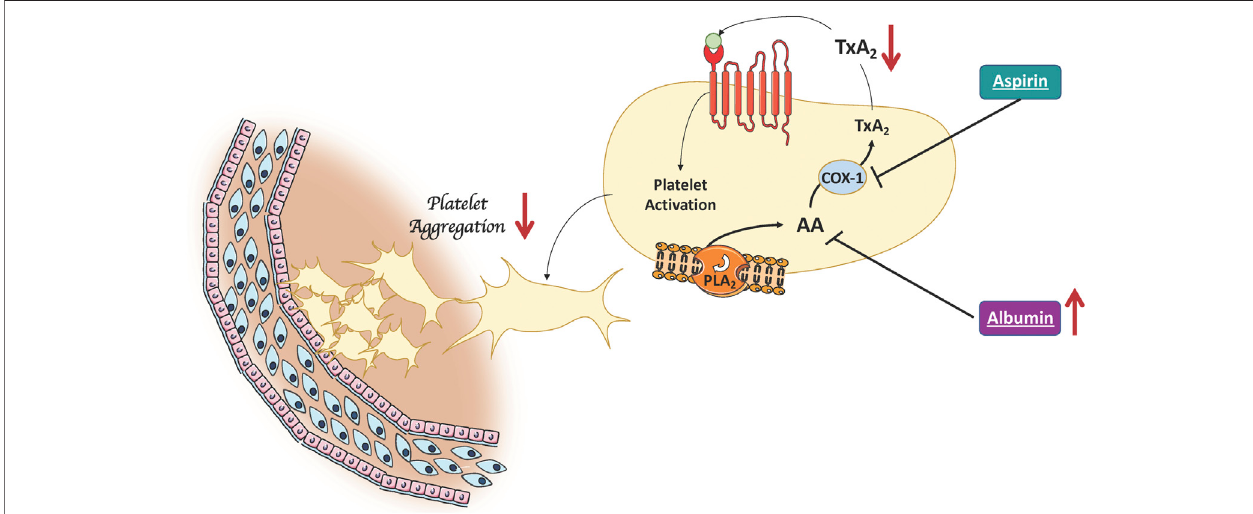
FIGURE2| Albuminlowersplateletaggregation.Highalbuminlevelsimprovetheclinicalef fi cacyofaspirinbybindingarachidonicacidreleasedbyPLA2-activation. This results in a decreased of platelet TxA2 production which in turn isno longer available for platelet activation (AA, Arachidonic Acid; COX-1, cyclooxygenase-1; PLA 2 , Phospholipase A2; TxA 2 , Thromboxane